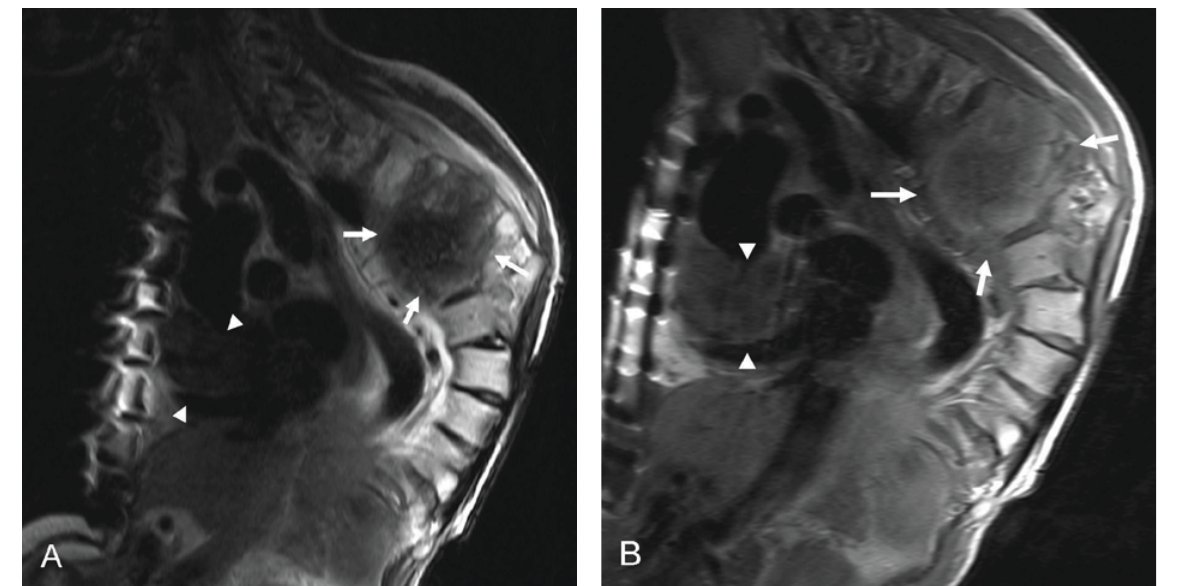
Figure 7. Thoracic vertebra MRI. A, sagittal plane T2 weighted and B, postcontrast T1 weighted images shows expansile T5 vertebra and cardiac metastases. Vertebral lesion is heterogenous hypointense in T2 weighted image and shows intense enhancement after contrast administration (arrows). Note that the intensity of the cardiac metastases is same with the vertebra metastases in T2 weighted image and both lesions enhance similarly